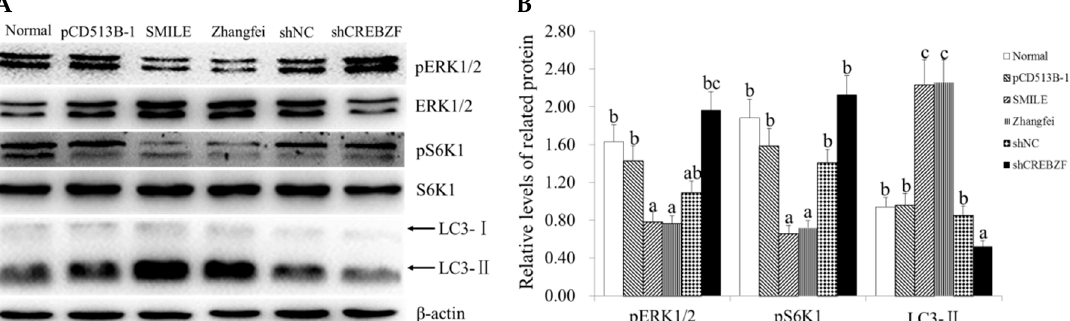
Figure 4. Effects of CREBZF overexpression and knockdown on ERK1/2 and mTOR signaling pathways in ovarian granulosa cells. ( A , B ) Expression of ERK1/2, pERK1/2, S6K1, pS6K1, LC3-I. and LC3-II in ovarian granulosa cells transduced with CREBZF lentivirus for 48 h. The statistical analysis is shown in the bar graphs. Data are presented as the mean ± SEM. The bars with different letters indicate significant differences ( p < 0.05), while the bars with the same letter indicate no difference between their respective values.